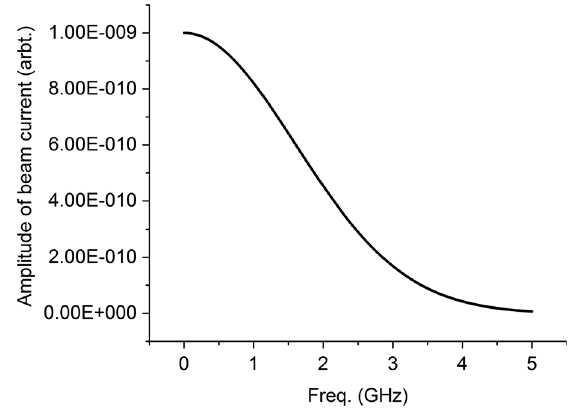
FIG. 5. Fourier transform of beam current used for the simulation of the test BPM with particle